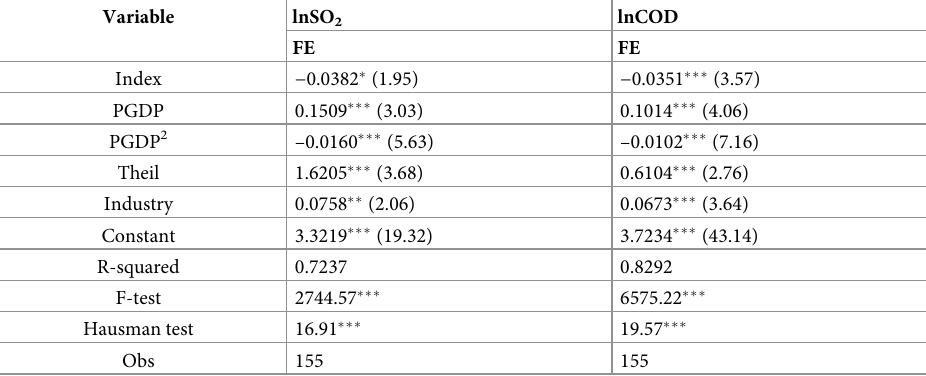
Table 2. Regression results of benchmark